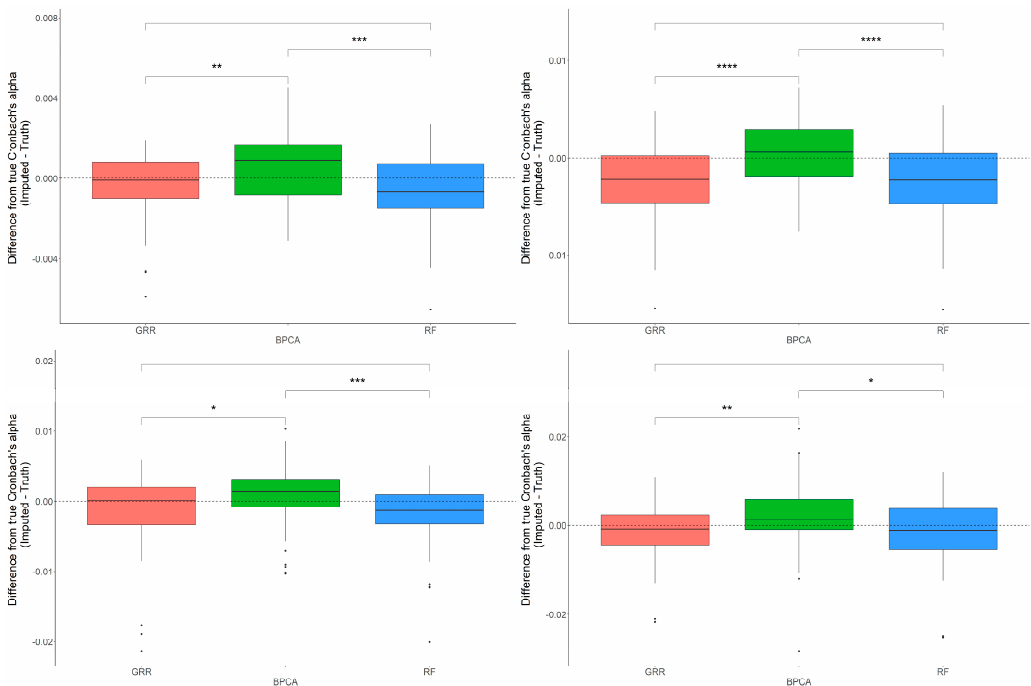
Figure 4. Evaluations of Cronbach’s alpha. Methods are listed across the x-axis, and the difference between the Cronbach’s alphas computed on the complete data and the imputed data is shown on the y-axis. The top row demonstrates differences in Cronbach’s alpha evaluated in the baboon plasma samples for 10% and 20% of overall missingness. The bottom row shows the differences in Cronbach’s alpha evaluated in the baboon liver samples for 10% and 20% overall missingness. The center line represents the median. The lower and upper box limits represent the 25% and 75% quantiles, respectively. The whiskers extend to the largest observation within the box limit ± 1.5 × interquartile range. Black dots represent single iterations of evaluating Cronbach’s alpha that are outliers. The p -values are based on pairwise testing with the Wilcoxon Rank Sum test (* corresponds to p ≤ 0.05; ** corresponds to p ≤ 0.01; *** corresponds to p ≤ 0.001; **** corresponds to p ≤ 0.0001).